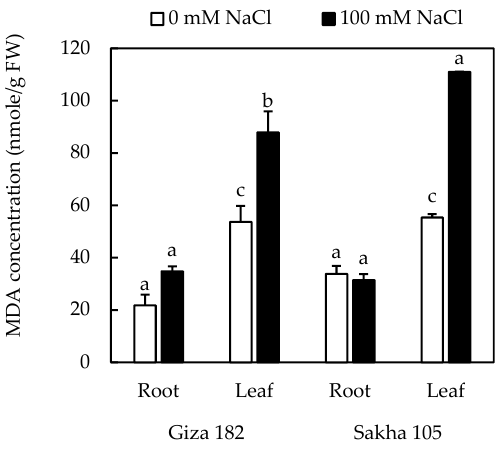
Figure 5. Malondialdehyde (MDA) concentration in the roots and leaves of Giza 182 and Sakha 105 under control conditions and 100 mM NaCl stress for 14 days. The bars represent means ± SE (standard errors) ( n = 4), FW: fresh weight. The bars with same letter on the top are not significantly different ( p ≤ 0.05).